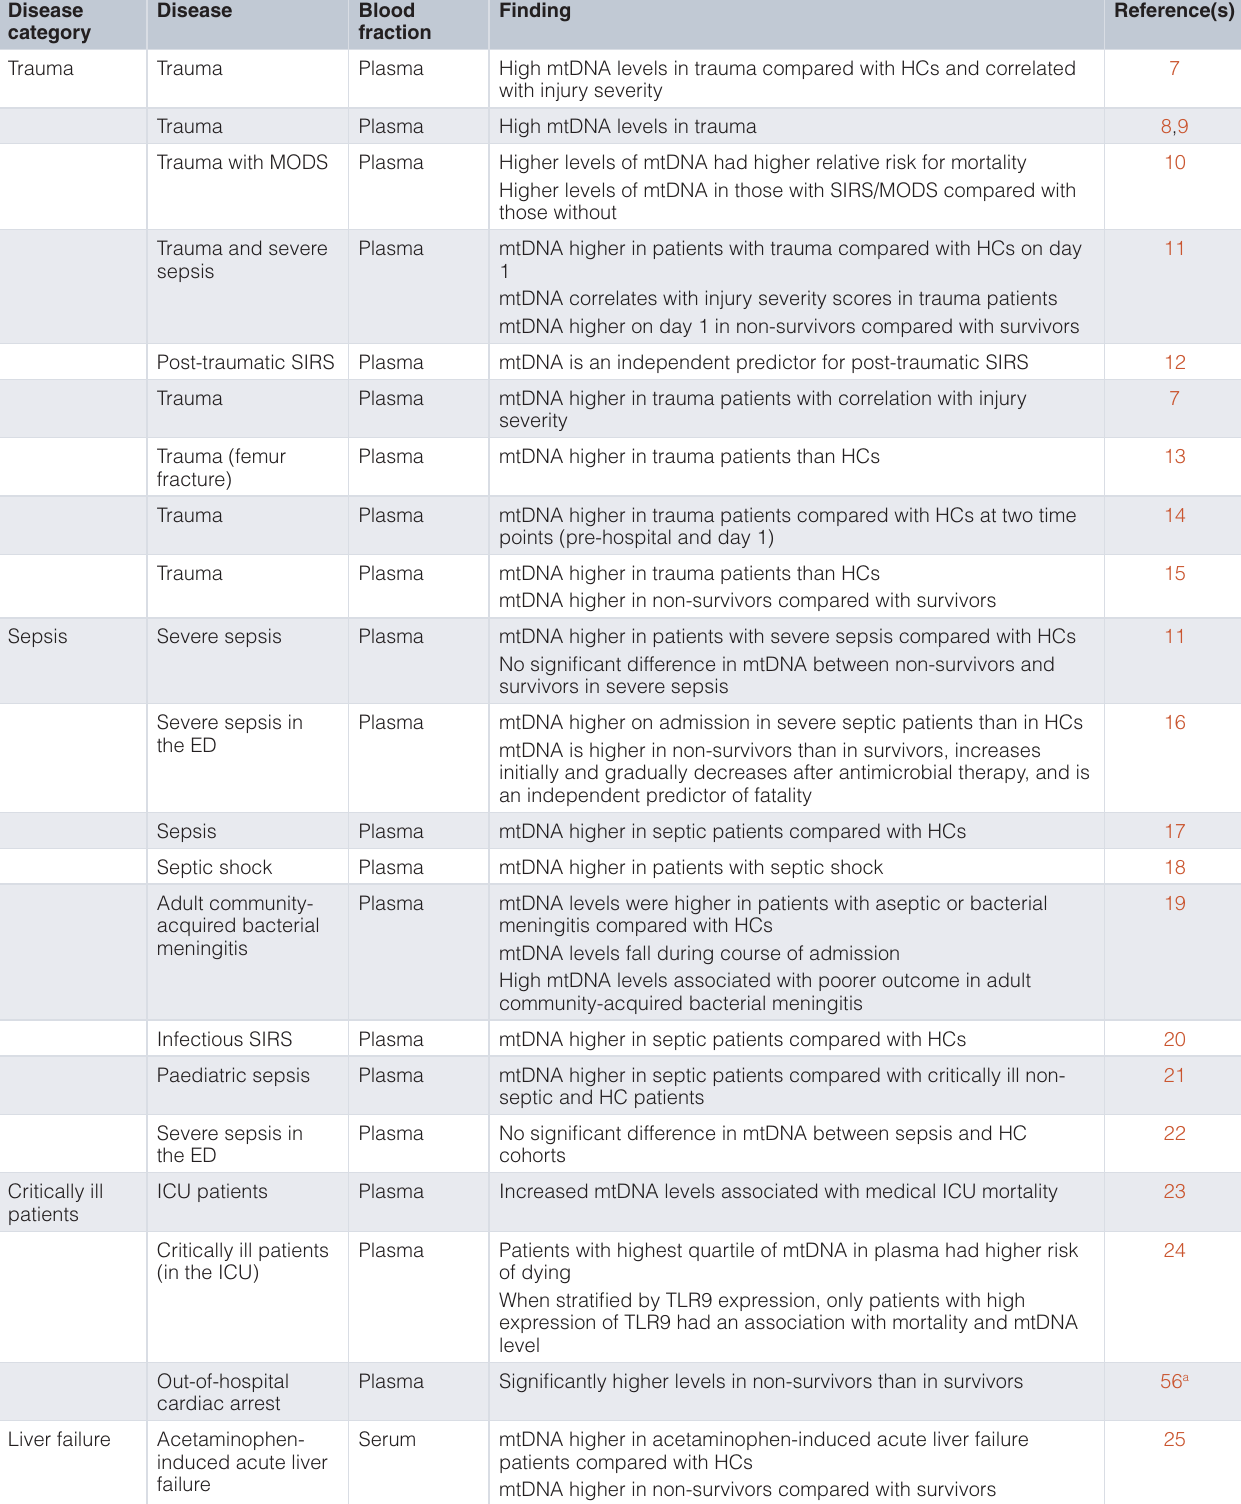
Table 1. Circulating mitochondrial DNA in human disease. Disease